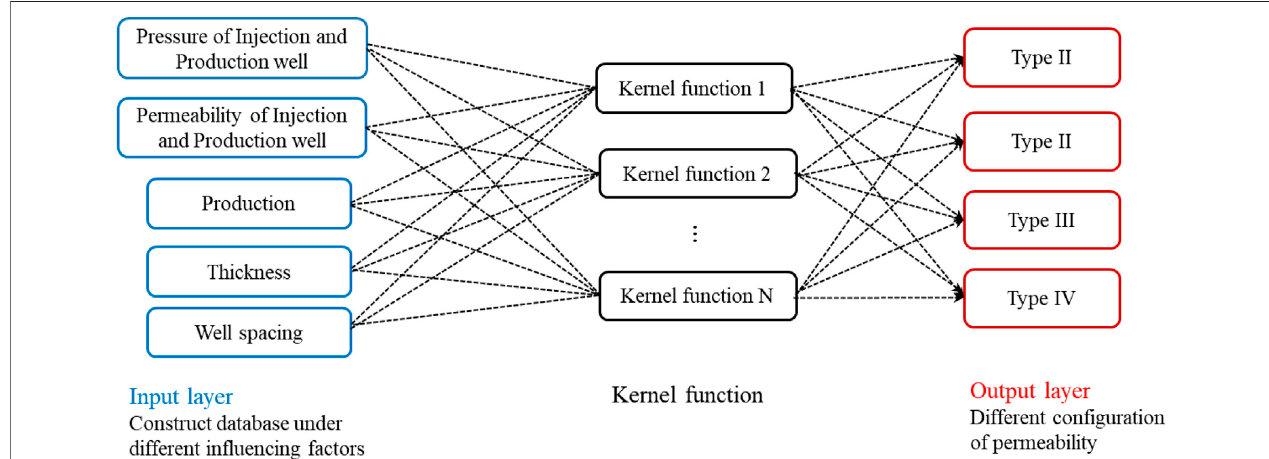
FIGURE 4 | The structure of support vector machines.